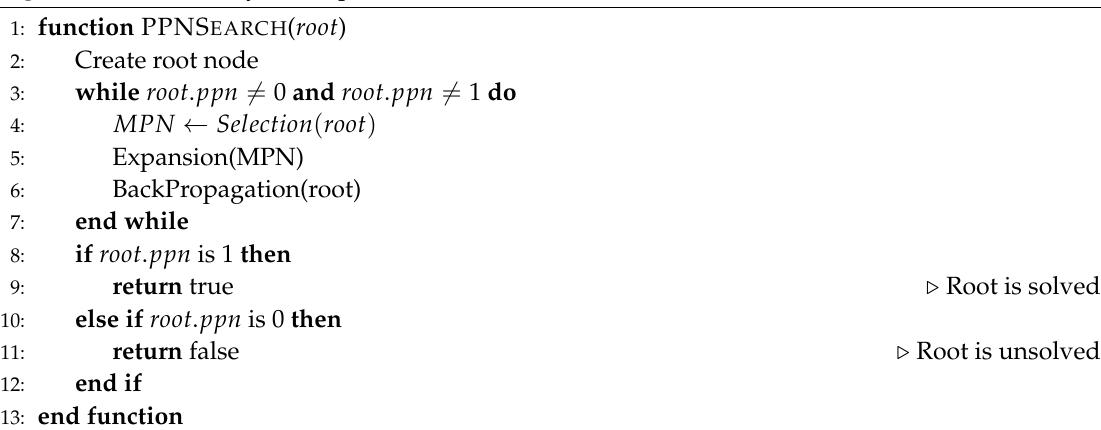
Algorithm 5 Probability-based proof number